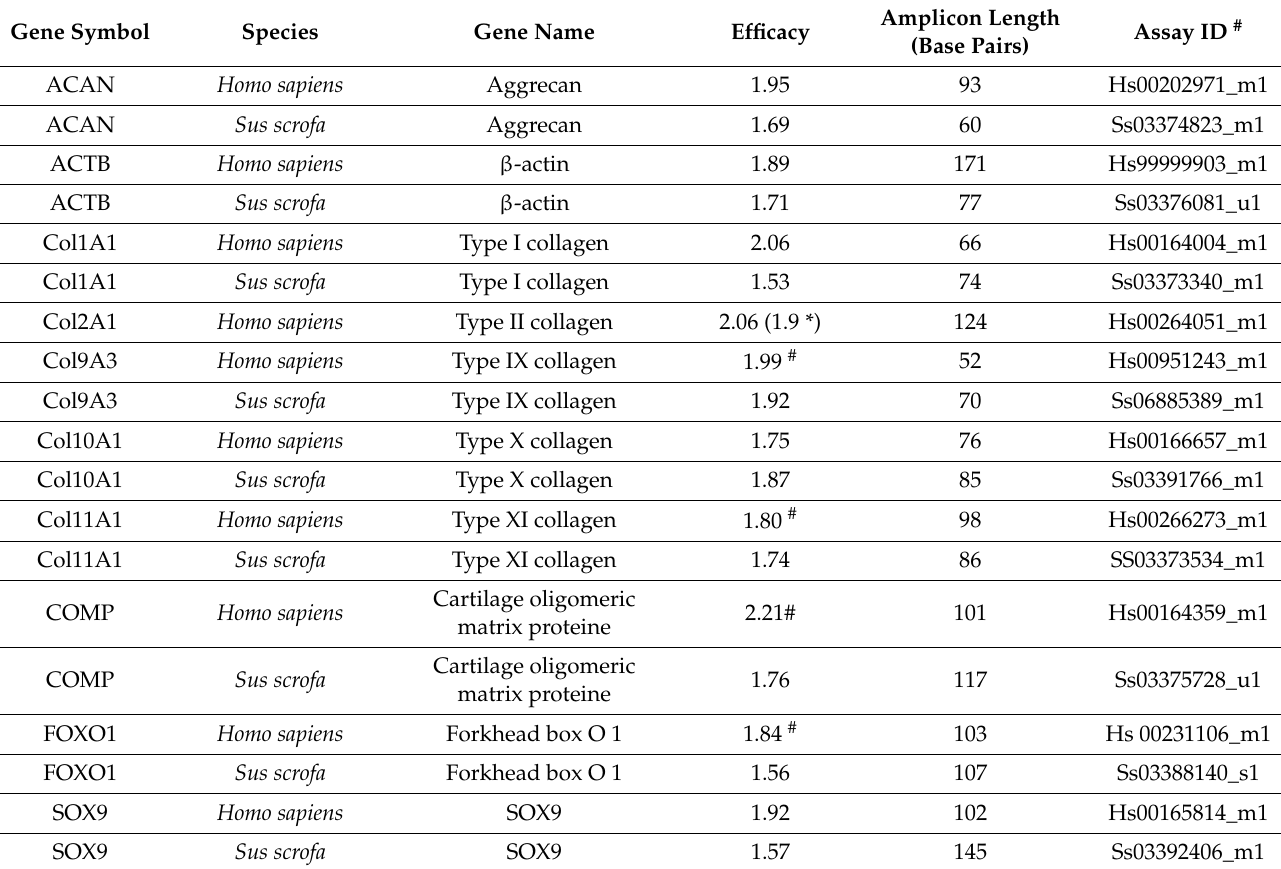
Table 3. Detailed information of primers used in the present